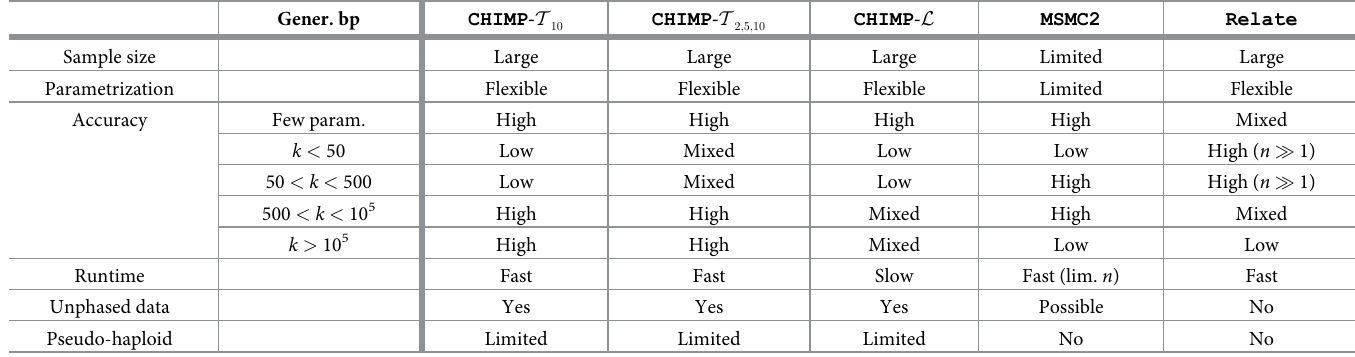
Table 4. Summary of the performance and features of the different methods compared in our simulation study. The ranges are given in generations before present. Gener.